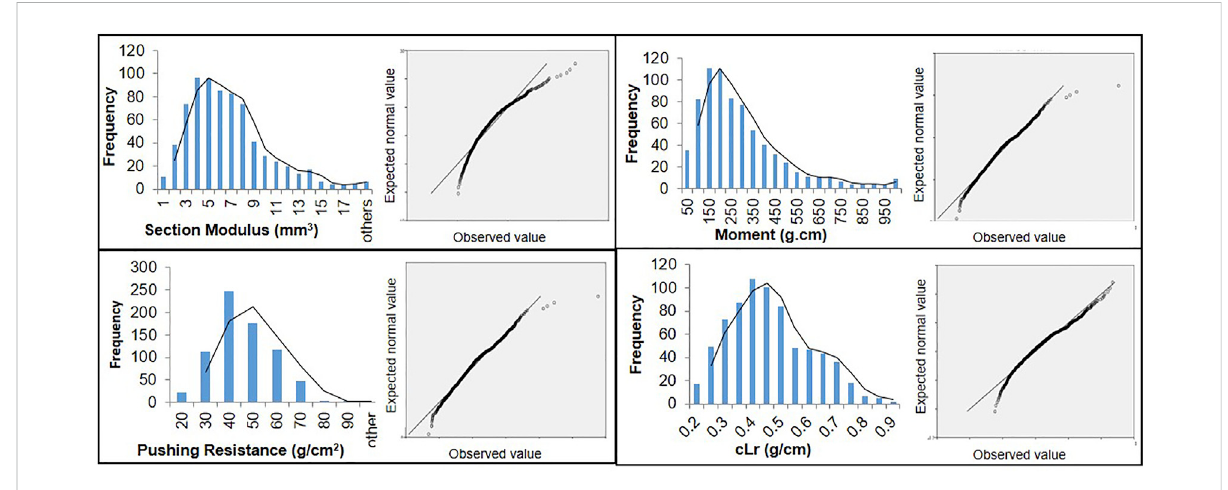
FIGURE 1 Frequency distribution and Q-Q plots of 795 genotypes of a globally diverse population for four lodging resistance traits.